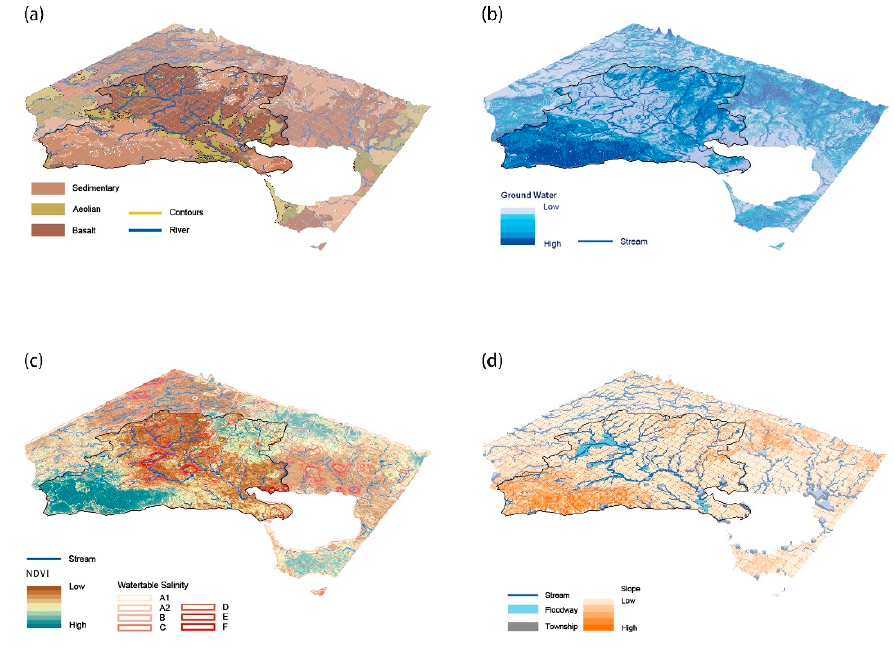
Figure 6. Spatial overlay and comparison of ecological suitability factors. ( a ) Land texture and stream; ( b ) Hydrology; ( c ) NDVI and Salinity; ( d ) Towns and land elements.